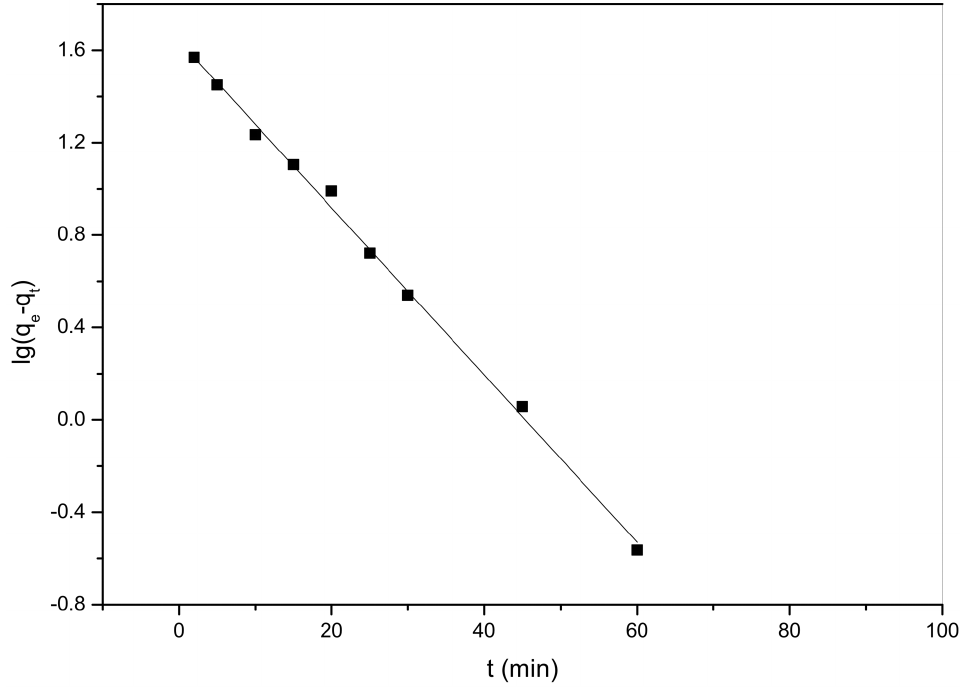
Figure 6. Plots of pseudo-first-order kinetic model equation for the biosorption of Cd 2 + on the Sargassumfusiforme . doi:10.1371/journal.pone.0095242.g006 PLOS ONE |